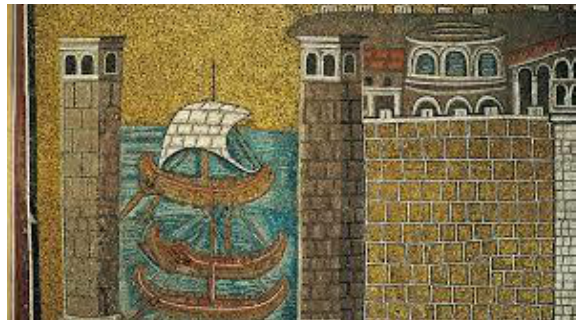
Fig. 10 The port of Classis (Sant’Apollinare nuovo, Ravenna, VI century)